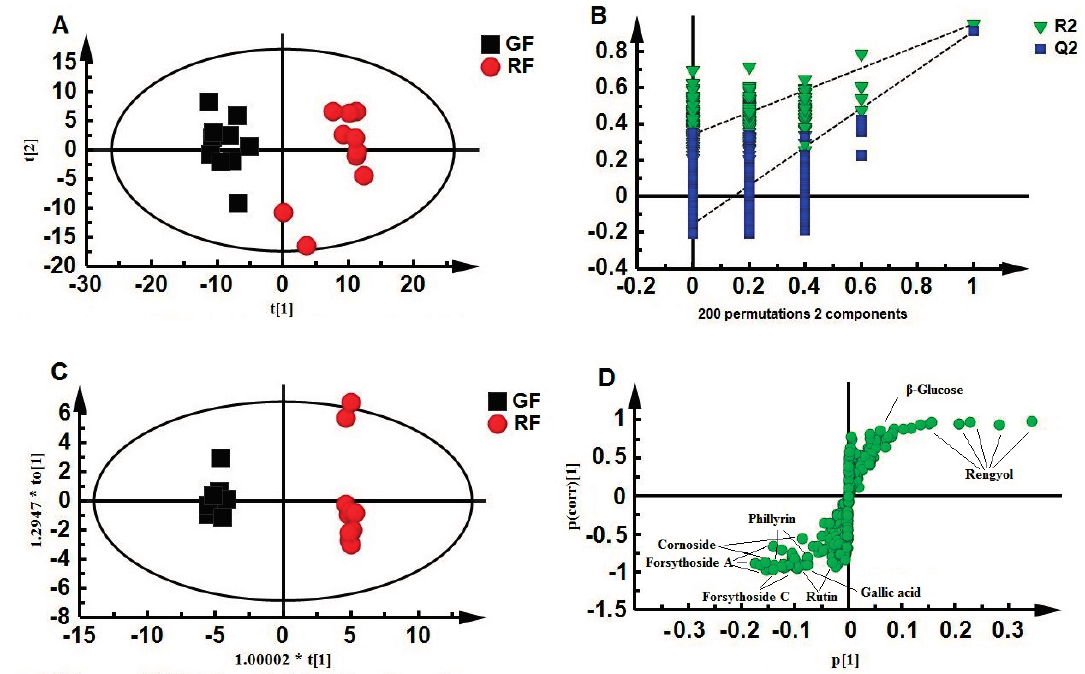
Figure 2. PCA score plots ( A ), permutation test with 200 permutations of the partial least square discriminant analysis (PLS-DA) model, R 2 = (0.0, 0.353), Q 2 = (0.0, − 0.111); ( B ) orthogonal PLS-DA (OPLS-DA) score plots ( C ) and S-plot ( D ) obtained from NMR metabolic profiles derived from aqueous methanol fractions of GF and RF: GF, black square; RF, red